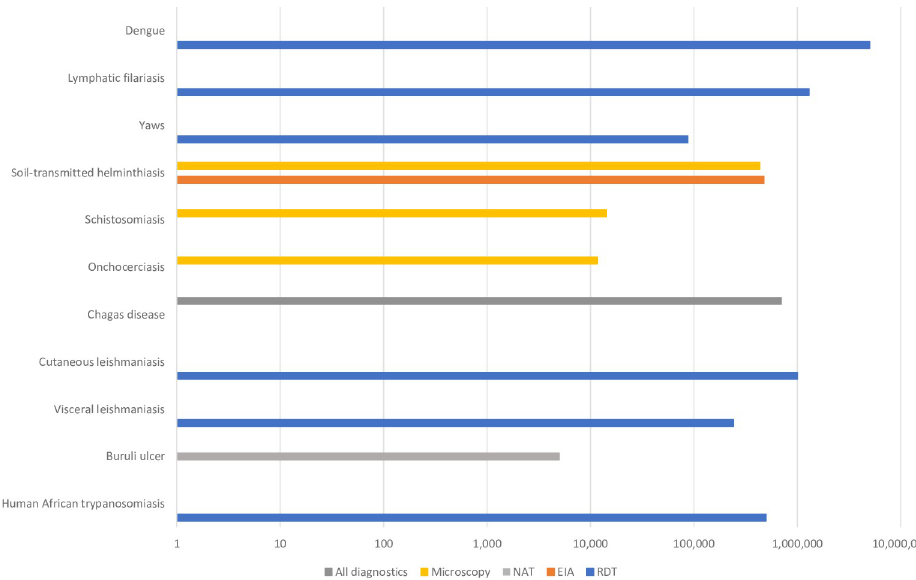
Fig 2. Estimated global need and market size for NTD diagnostics. (A) Volume of diagnostics for yaws, lymphatic filariasis, soil transmitted helminthiasis, visceral leishmaniasis, Buruli ulcer and human African trypanosomiasis (HAT) is based on median procurement volume for 2017–2019. (B) Volume of diagnostics for schistosomiasis and onchocerciasis is based on WHO Preventive Chemotherapy Epidemiological Data Reporting Form reported from endemic countries from 2017–2019. (C) For Dengue, Chagas, cutaneous leishmaniasis, for which procurement volumes were not available, market size was estimated based on global disease prevalence. For Chagas disease, the estimated volume is for any type of